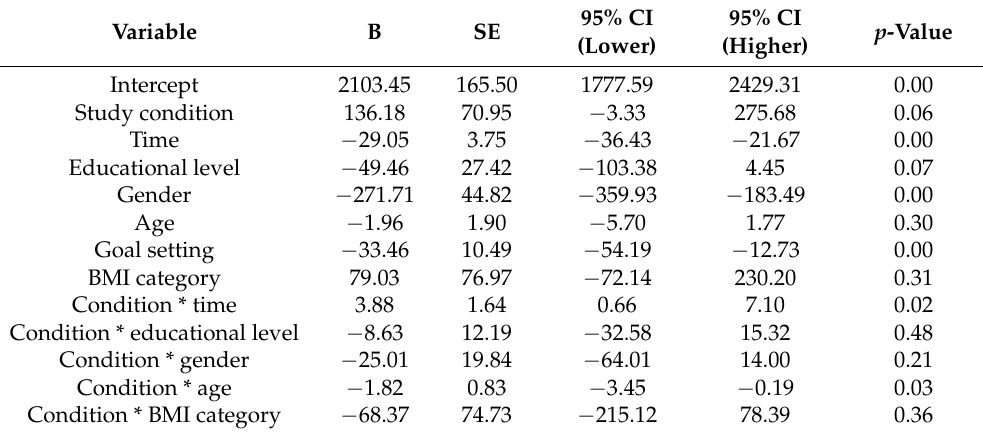
Table 2. Multilevel analysis with energy intake as dependent variable.